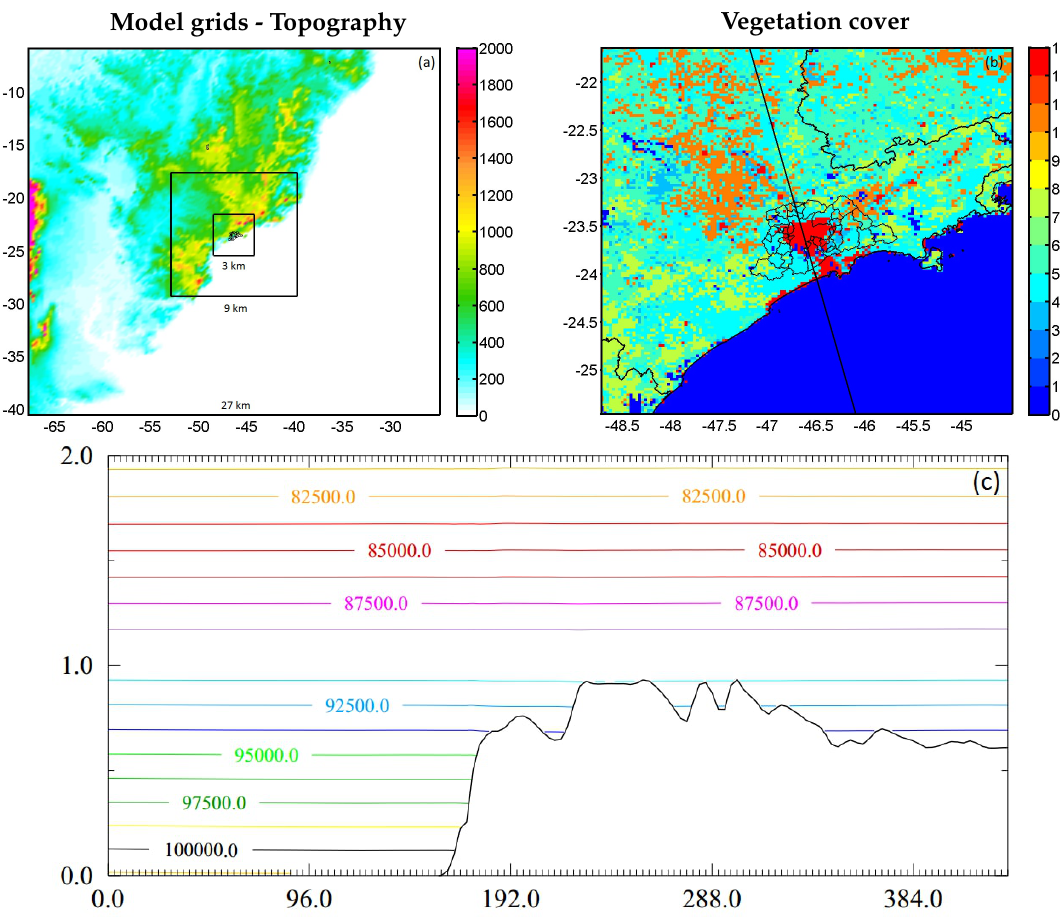
Figure 2. ( a ) The three model domains used in the simulations (27, 9 and 3 km), with the background showing the topography of the region of the inner domain (3 km). ( b ) Types of vegetation cover used in ARPS for inner most domain (3 km). (0) Water, (1) desert, (2) tundra, (3) grassland, (4) grassland with shrub cover, (5) grassland with three cover, (6) deciduous forest, (7) evergreen forest, (8) rain forest, (9) ice, (10) cultivation, (11) bog or marsh, (12) dwarf shrub and (13) semi-desert. The urban canopy replaced semi-desert canopy (13). ( c ) Elevation cross section for inner most domain (3 km) indicated by the black line in ( b ) and pressure fields in